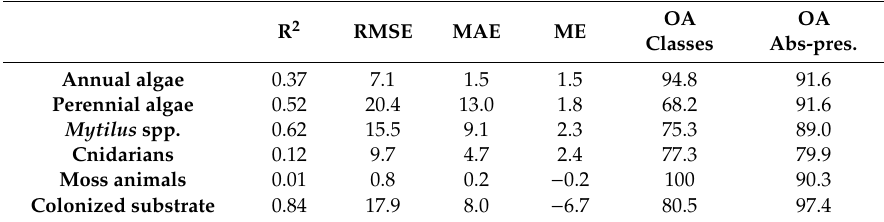
Table 13. Accuracy of percent coverage biological components (HUB level-5 groups) divided into map percent cover intervals. Distribution of the ground-truth dataset divided into HUB 4–6 classes are available in Table A5. Accuracy was measured (testing data, observed vs. predicted) with mean error (ME) and standard deviation (SD).